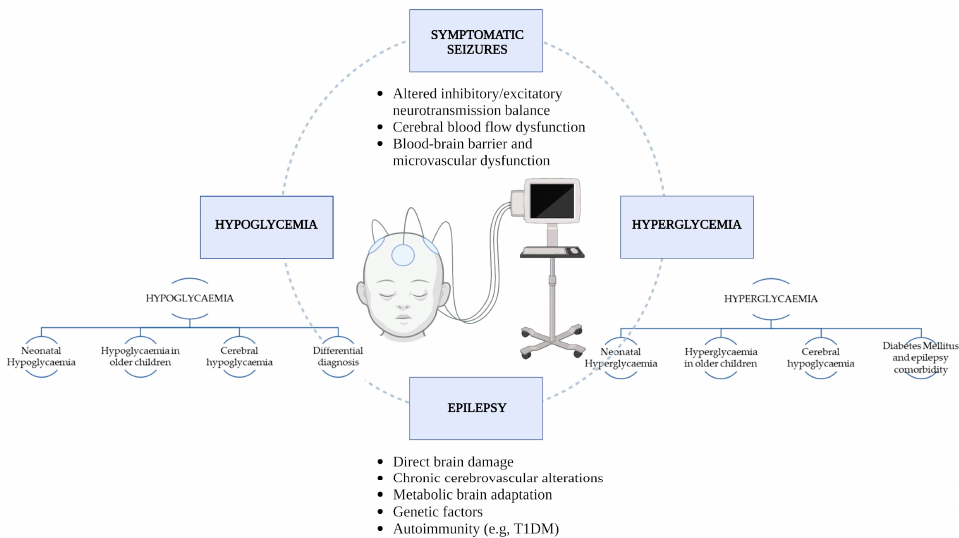
Figure 1. Flow chart summarizing the main themes of the review and the potential mechanisms implicated in the pathophysiology of epilepsy in the context of hypo- and